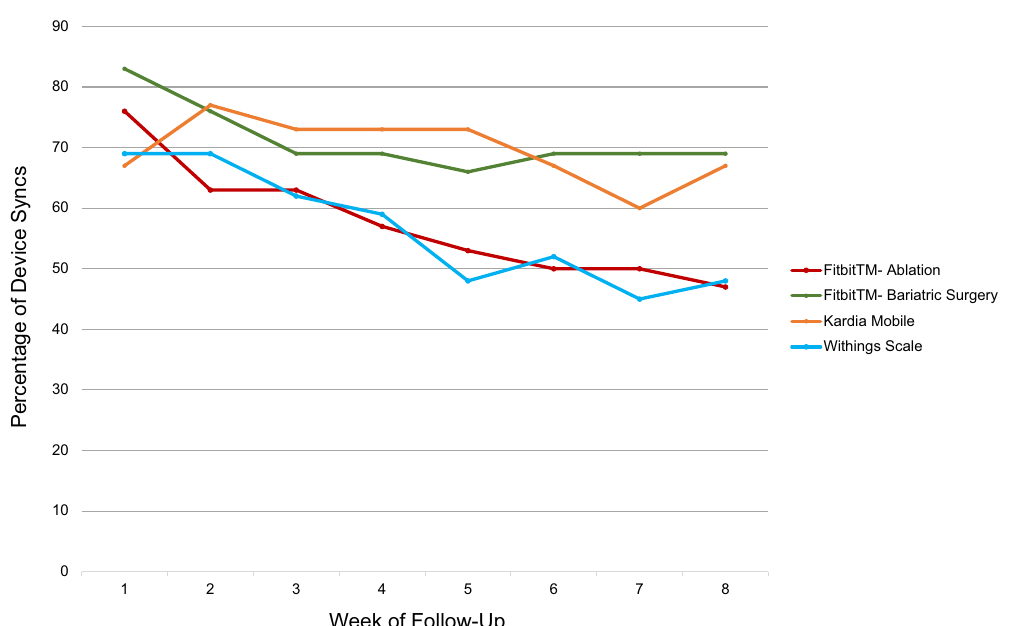
Fig. 1 Rates of weekly personal digital device use and syncing over 8-week follow-up period among patients after bariatric surgery or atrial fi brillation ablation ( n = 59). Data obtained over 8-week follow-up period for Fitbit Charge 2 TM (all patients), Kardia Mobile (ablation patients only), and Withings Body Scale (bariatric surgery patients only). Procedure occurred at week zero.